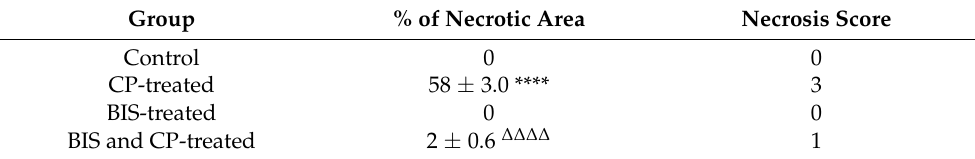
Figure 8. Urine levels of 8-hydroxy-2-deoxyguanosine (8-OH-dG, ( A )) and pteridine ( B ) in mice treated orally with either sunflower oil (control) or bisabolol (BIS, 25 mg/kg) with or without cisplatin (CP, 20 mg/kg) given intraperitoneally (n = 6). Mean ± SEM. Statistical analysis by ANOVA 1 followed by Holm–Sidak’s test. Table 1. Histopathological analysis and scoring of renal sections of mice treated orally with either sunflower oil (control) or bisabolol (BIS, 25 mg/kg) with or without cisplatin (CP, 20 mg/kg) given